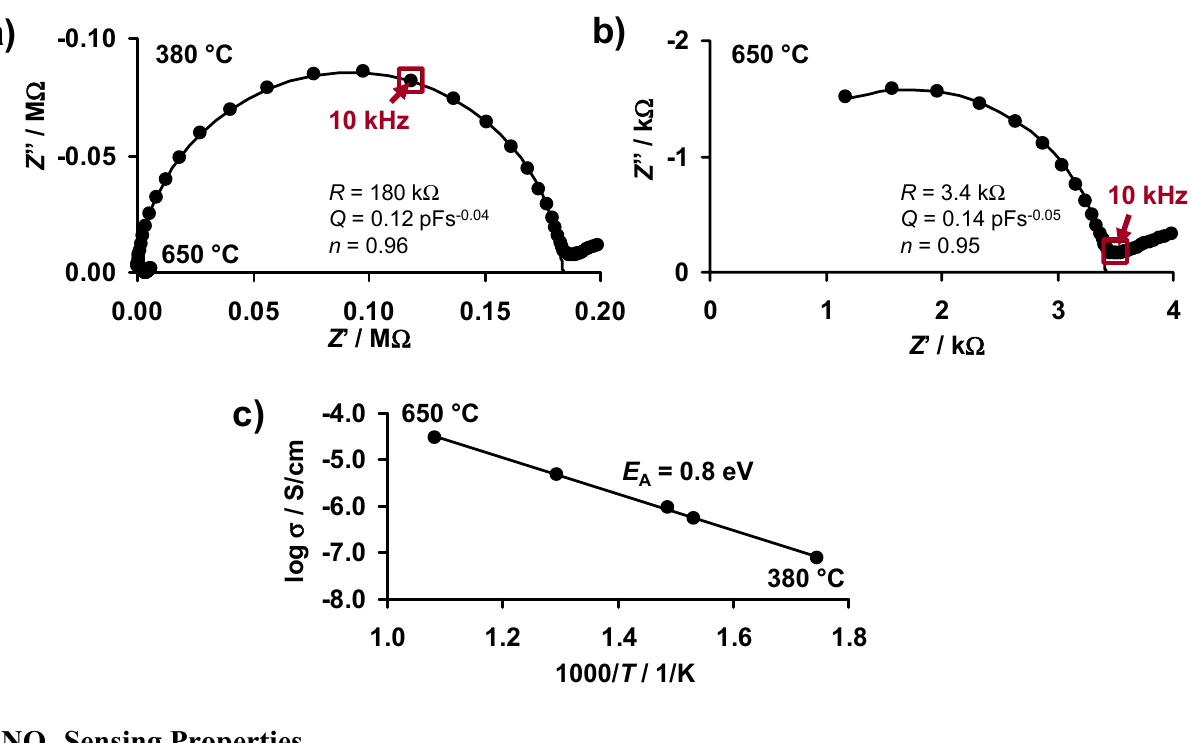
Figure 3. Thermal activated conductivity of KMnO impedance Z at 380 and 650 °C, ( b ) enlargement of 650 °C data, ( c ) Arrhenius-like representation of conductivity σ from 300 to 650 °C. Further time-continuous impedance measurements were conducted at 10 kHz (see Section 3.1) and the 10 kHz data points in ( a ) and ( b ) are